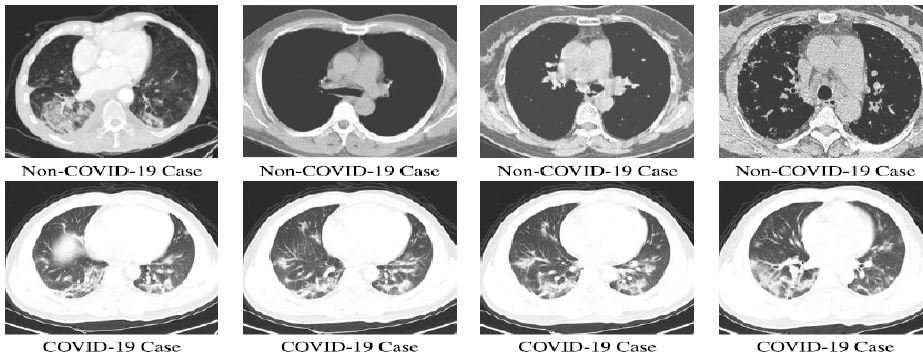
Figure 6. Sample CT image Dataset.